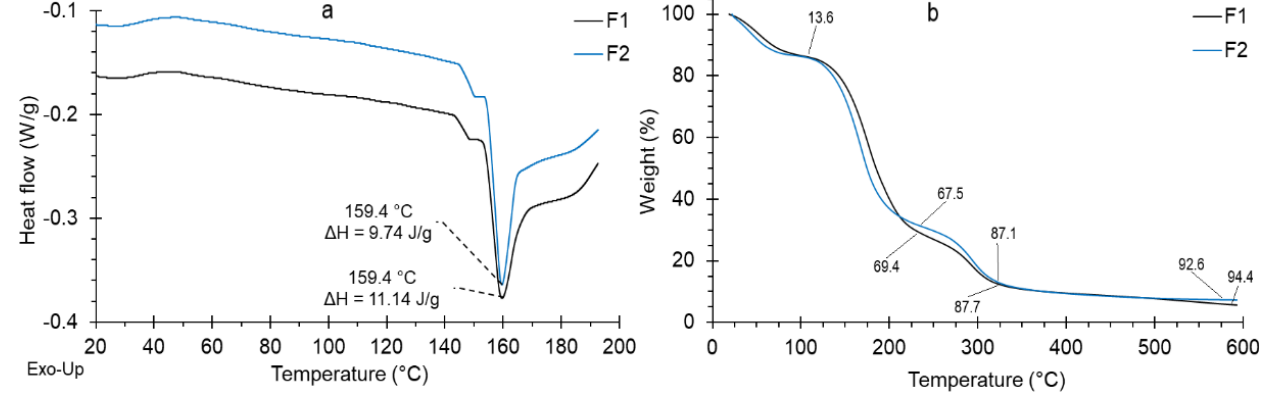
Figure 2. Thermal analysis of coatings, ( a ) DSC, ( b ) TGA.